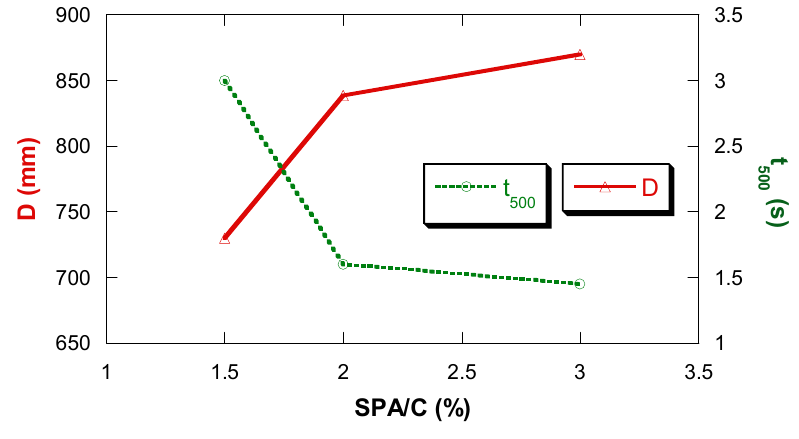
Figure 9. Slump flow test results.